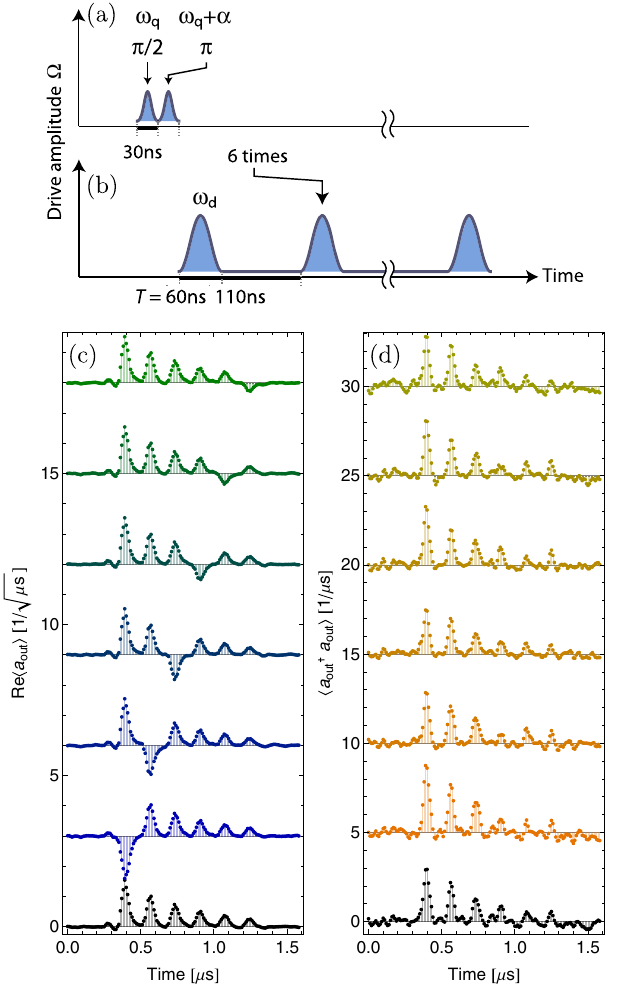
FIG. 4. (a) Amplitude of the drive signal used to initialize the transmon and (b) transfer the excitation into the resonator to generate a multipeaked photon shape. (c) The real part of the measured output field a as a function of time for six-peak out photons with phases of each of the peaks flipped by π one by one. The bottom-most trace is a reference with all peaks having the same phase. (d) Averaged emitted power as a function of time for the same photon pulses as in